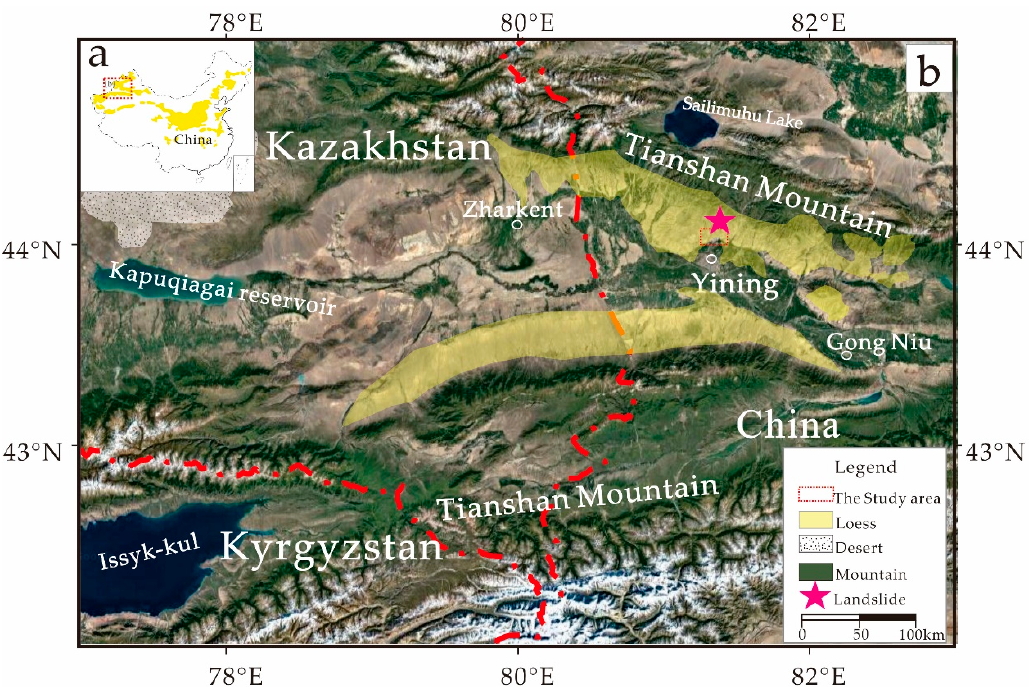
Figure 1. Location map of the Panjinbulake loess landslide ( a is modified from [33]; b is modified from [48]). ( a ) The distribution of loess in China. ( b ) The distribution of loess in the study area.